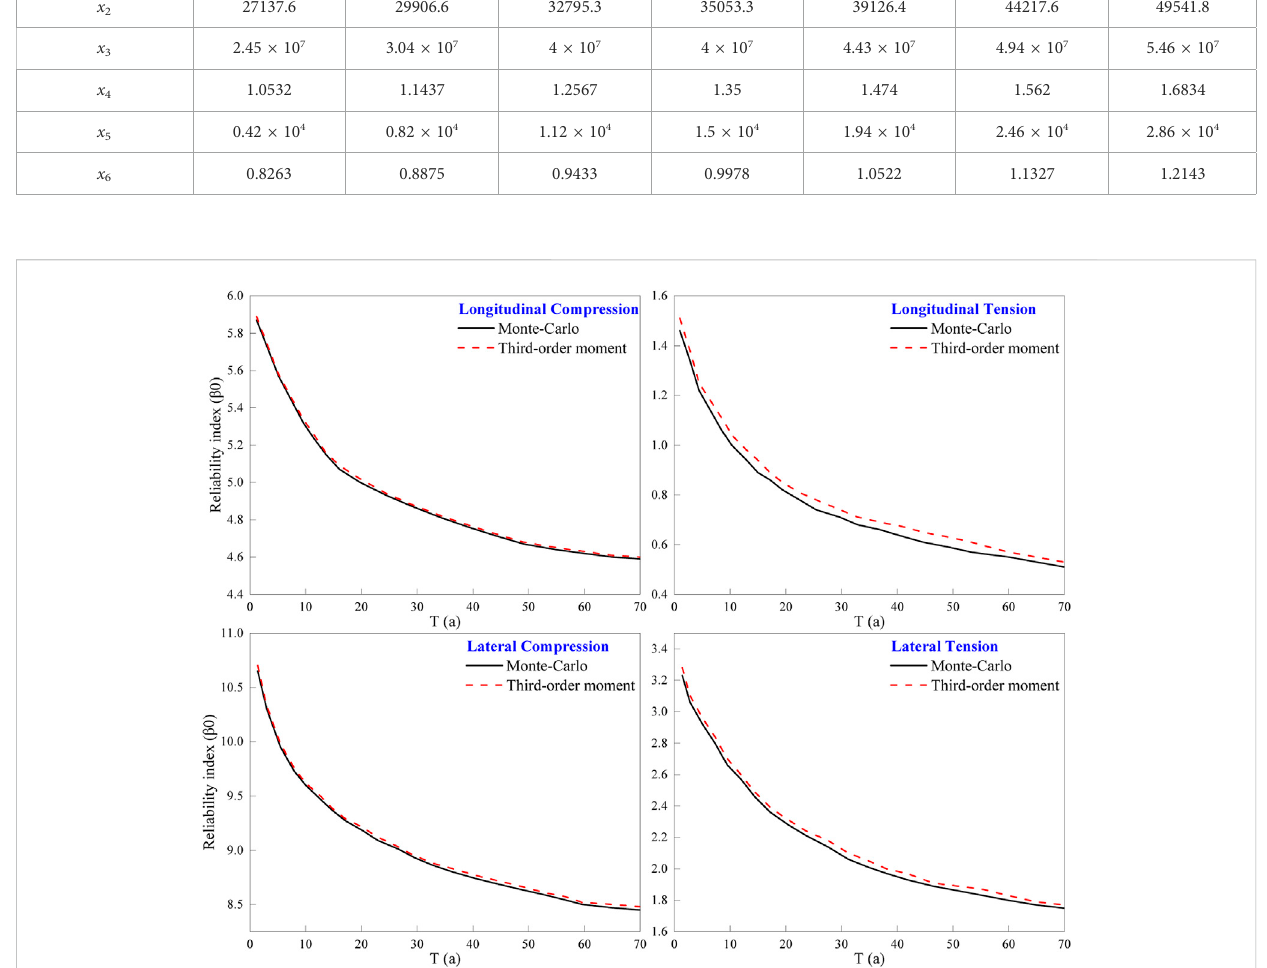
FIGURE 3 Variation of time-varying fatigue reliability of invert structures of subway